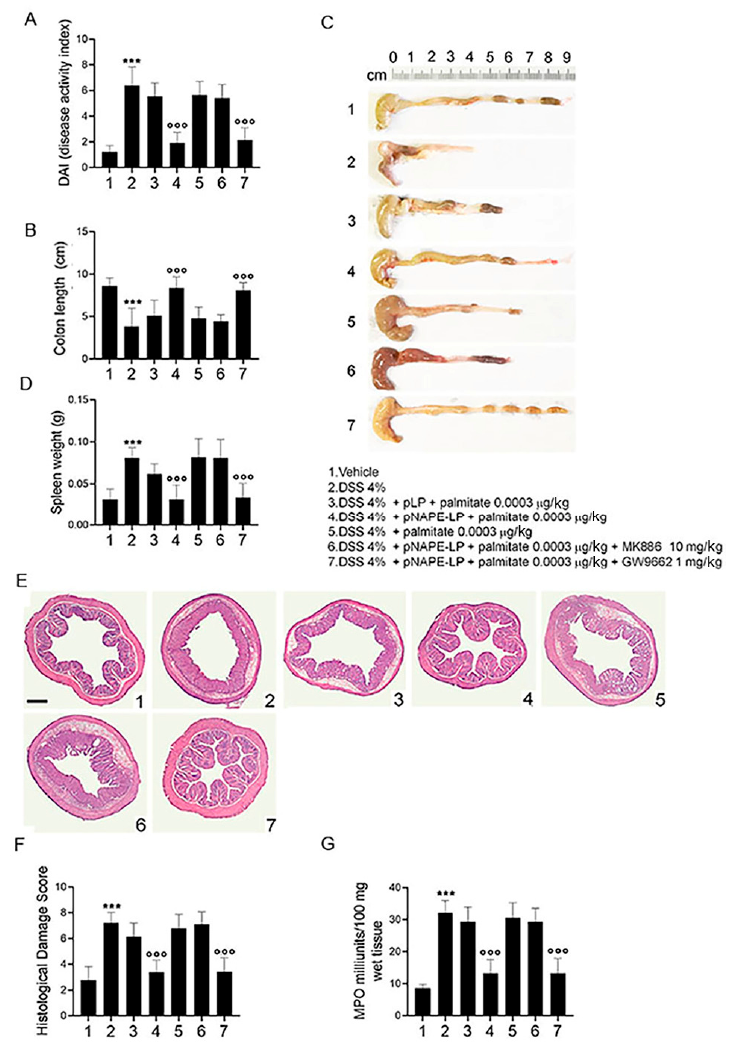
Figure 2. Engineered pNAPE-LP + palmitate ameliorates macroscopic signs of colitis, prevents colonic histological damage and neutrophil infiltration in DSS-treated mice. PPAR α -dependent effects of pNAPE-LP + palmitate treatment on ( A ) DAI score, ( B , C ) colonic length and ( D ) spleen weight in DSS-exposed mice. ( E ) Representative images of hematoxylin and eosin (H&E) stained distal colon sections and ( F ) relative histological damage score showing the effect of pNAPE-LP + palmitate on DSS-induced colonic injury; magnification 4×; scale bar: 200 μ m. ( G ) Myeloperoxidase (MPO) activity quantification as indirect evidence of neutrophils infiltration. Results are expressed as the mean ± SD of n = 5 experiments. *** p < 0.001 versus vehicle; °°° p < 0.001 versus DSS-treated mice.